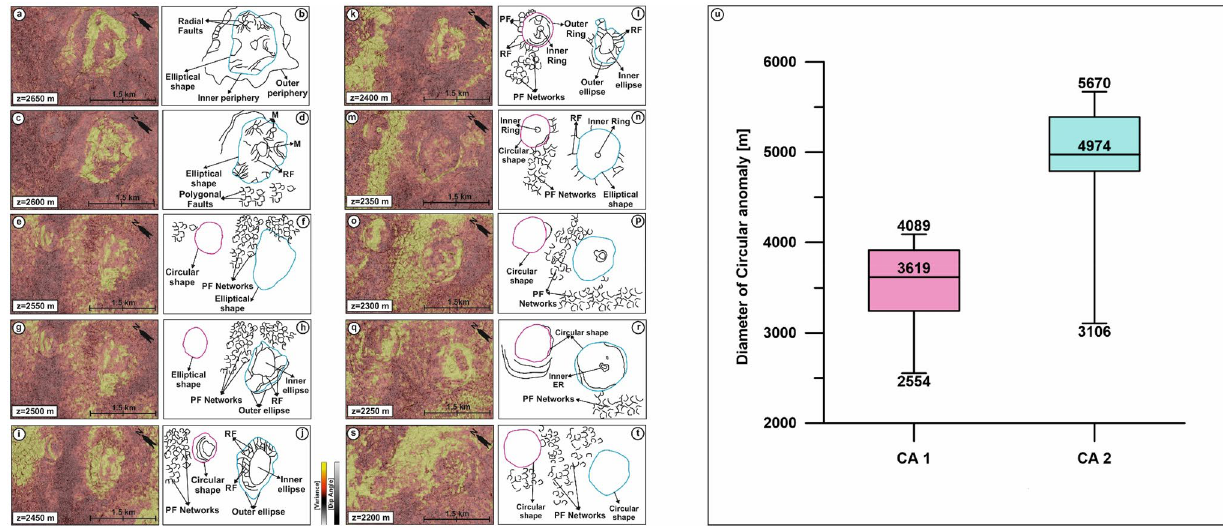
Figure 9. ( a – t ) Circular Anomalies (CA 1 in the blue oval and CA 2 in the red oval) and the corresponding interpretation sketches observed at depths ~ 2650–2200 m through the Eocene to the MPC intervals. The depth maps are prepared co-rendering the variance and dip-angle attributes; ( u ) Box-whisker pot showing the variation in the diameter for the observed circular anomalies i.e., CA 1 and CA 2